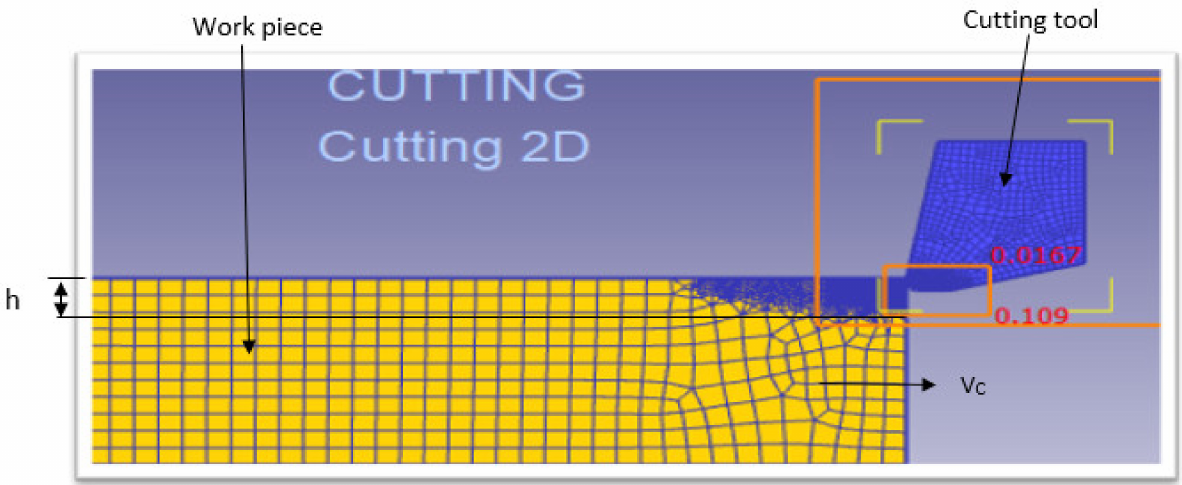
Figure 3. Meshing of the model for cutting simulation at V c = 104 m/min, f = 0.1